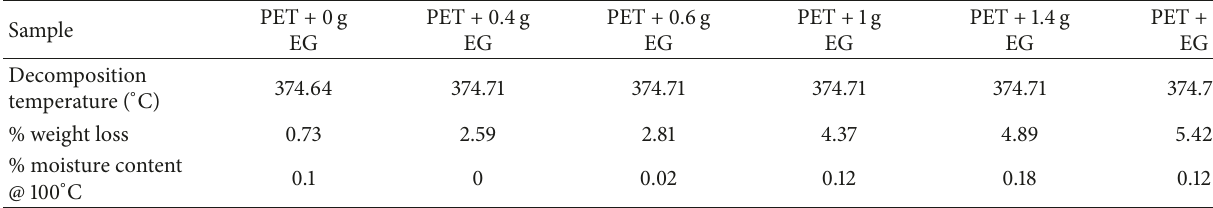
Figure 2: (a) TGA curves and (b) DTG analysis for the untreated and EG treated PET. Table 1: Total weight loss of all